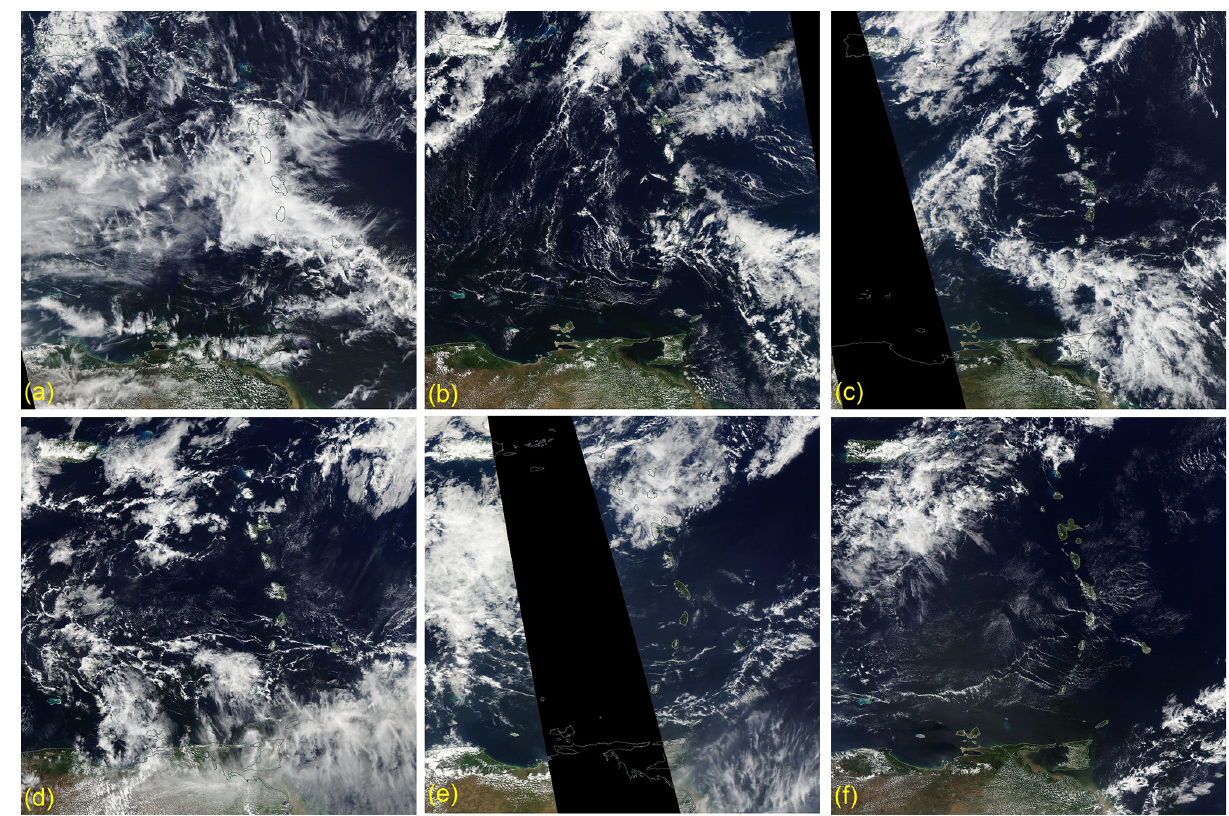
Figure 13. Visible images from MODIS Aqua around 13:30UTC on each day between 22 and 27 January 2020 (from left to right and top to bottom). Source: NASA WorldView (https://worldview.earthdata.nasa.gov/, last access: 29 January 2021).